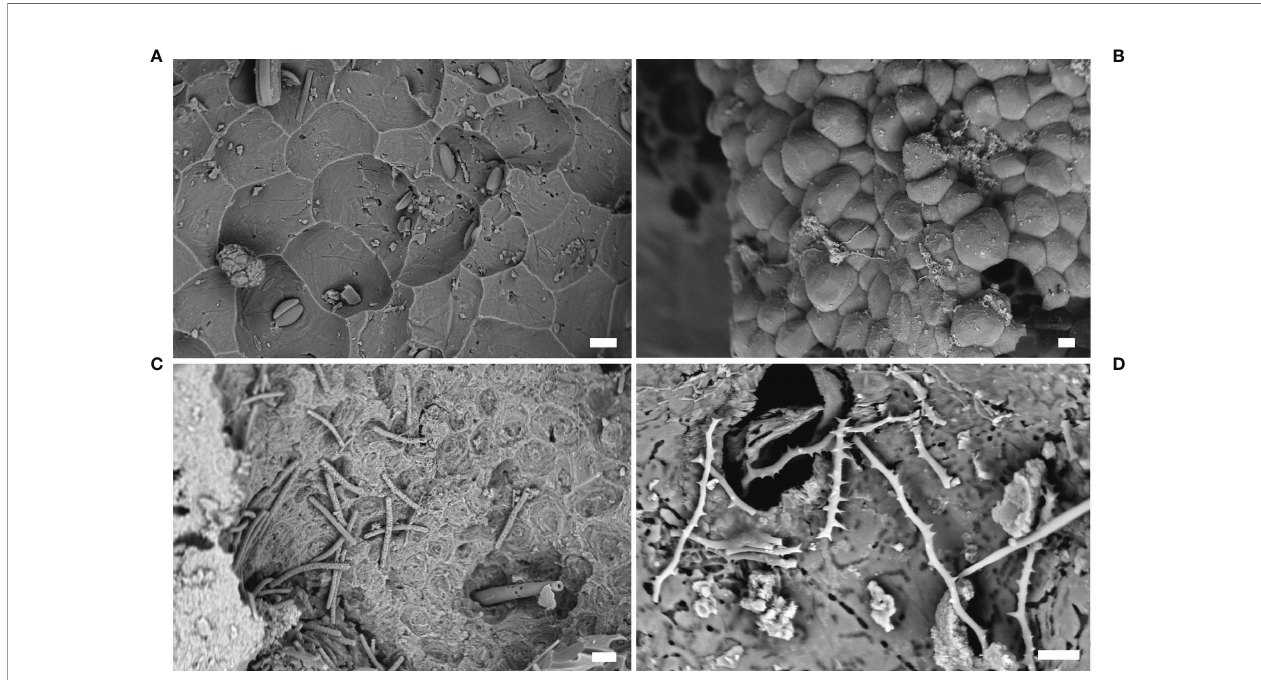
FIGURE 6 | Sponges. (A) Microbioerosion pattern produced by Cliona celata , marble statue from Baiae (SEM image); (B) resin cast ( Entobia isp.) of erosion chambers produced by Cliona sp. (SEM image); (C) spicules and pits in an erosion chamber produced by Dotona pulchella mediterranea (SEM image); (D) spicules of C . schmidtii inside a eroded chamber (SEM image). Scale bars: (A – C) = 20 µm; (D) =10